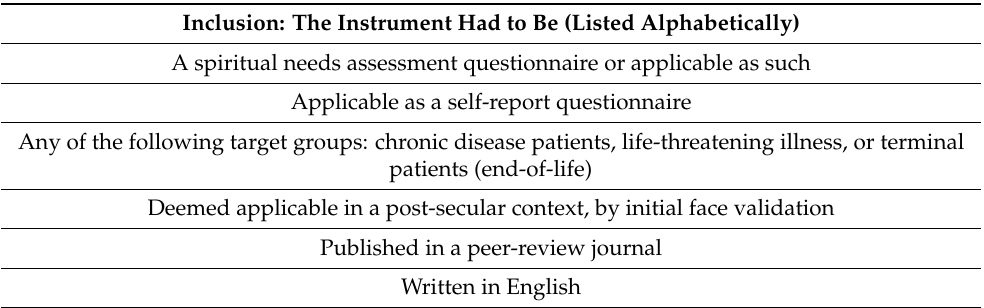
Table 1. Criteria for inclusion.